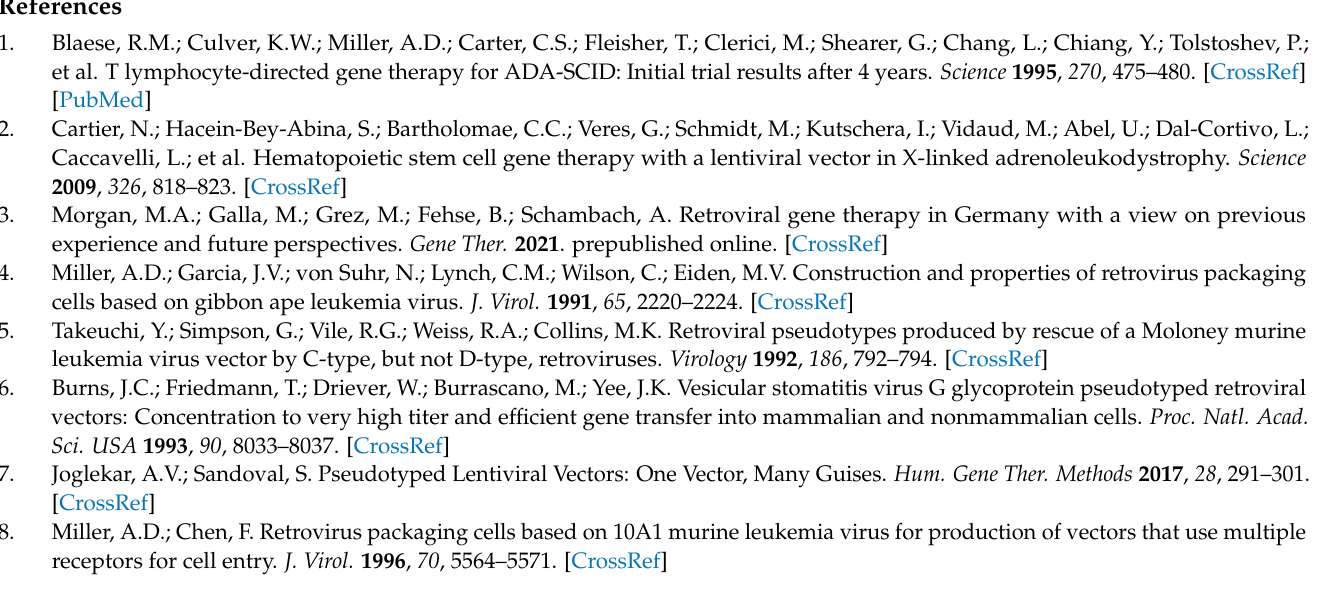
Figure S3: Dose-finding of coGALV-env plasmid amount needed for efficient packaging of lentivi- ral